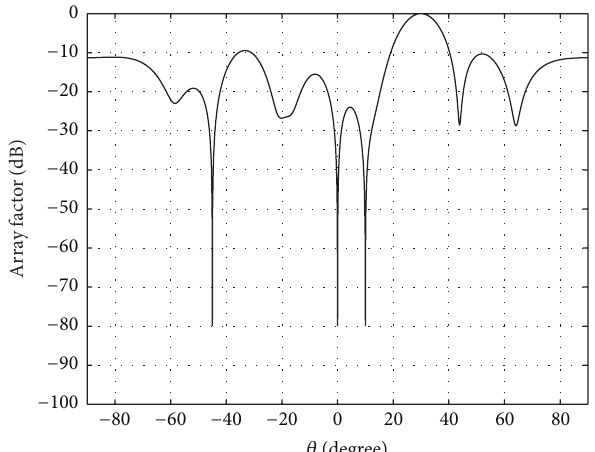
Figure 5: Resultant beam pattern designed ( 𝑁 = 10 ) by the feed- back function of